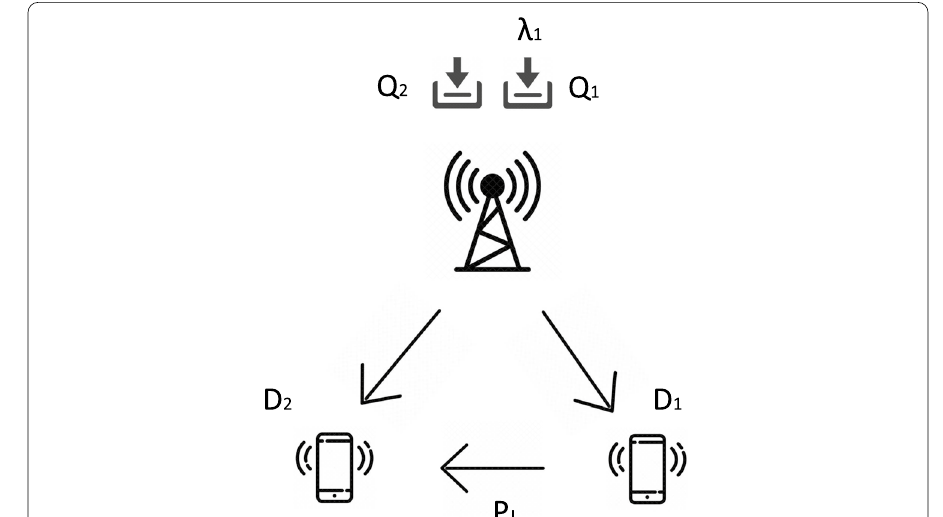
Fig. 1 Two-user broadcast channel with secrecy